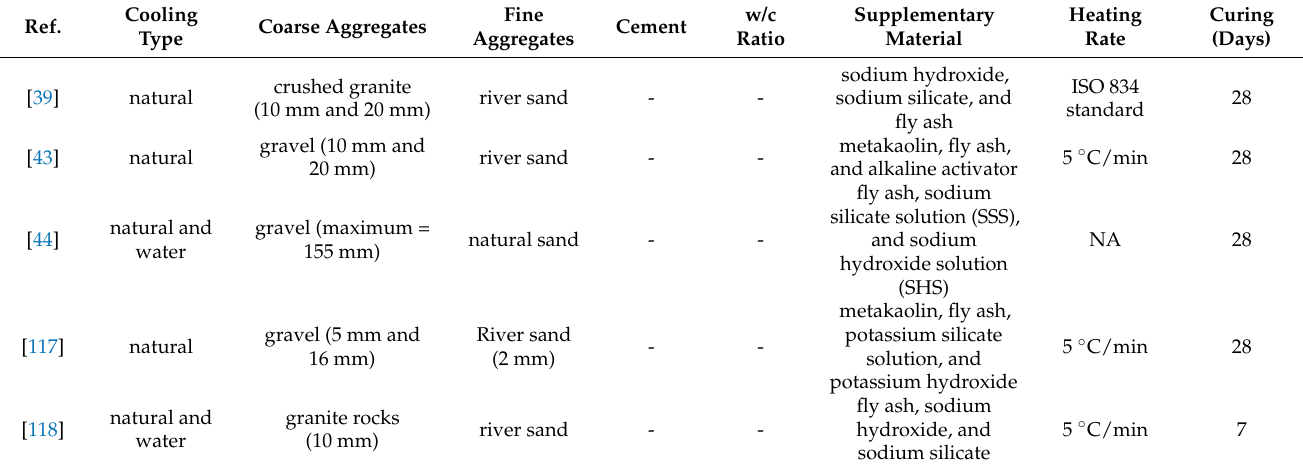
Table 7. Important parameters of different studies on GPC